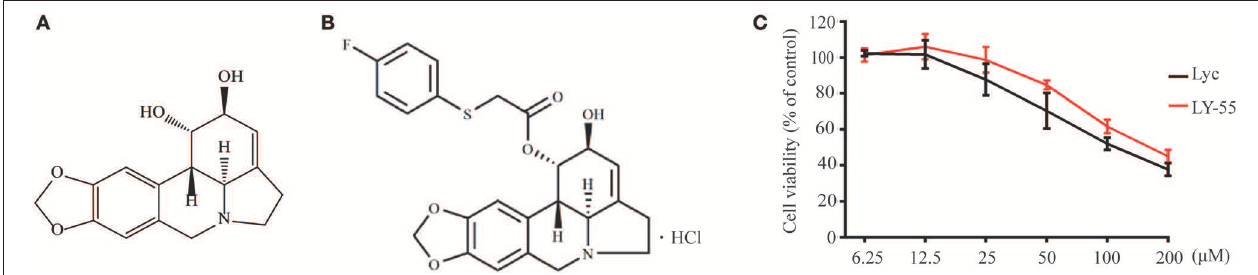
FIGURE 1 | Chemical structure of compounds and CCK assay. (A) Chemical structure of lycorine. (B) Chemical structure of LY-55. (C) CCK assay of compounds.